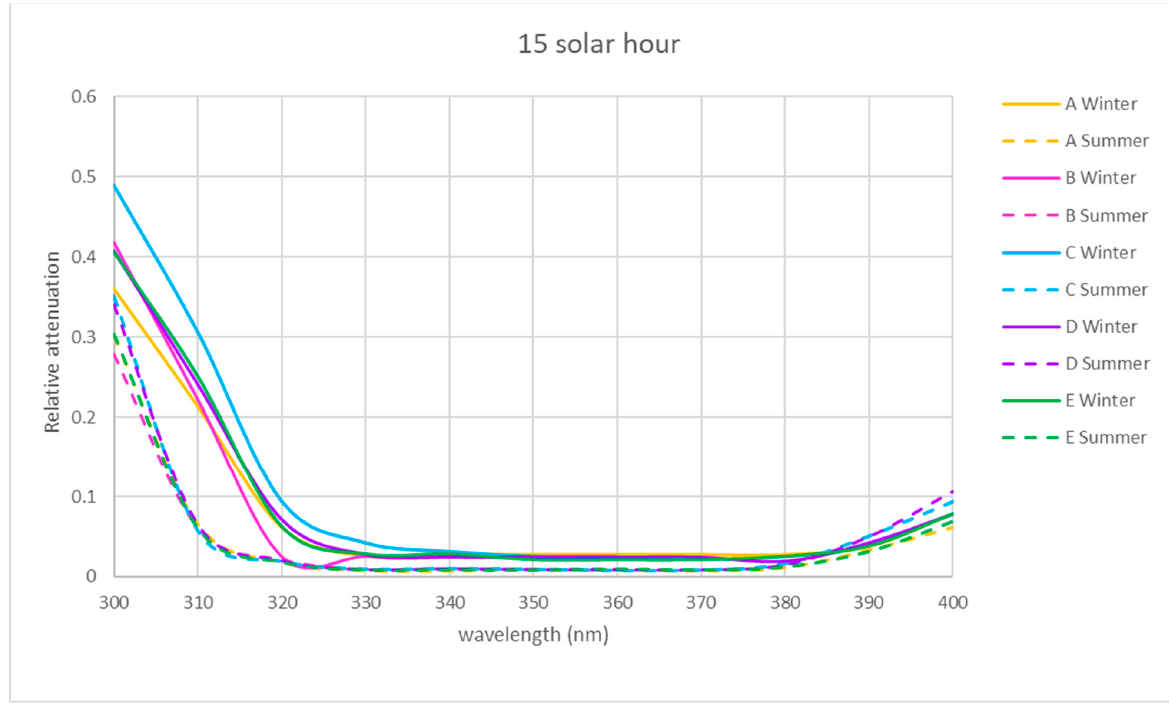
Figure 7. Representation of the spectral relative attenuation for the UV band for the 5 locations studied in the two seasons of the year at 15 h solar time.